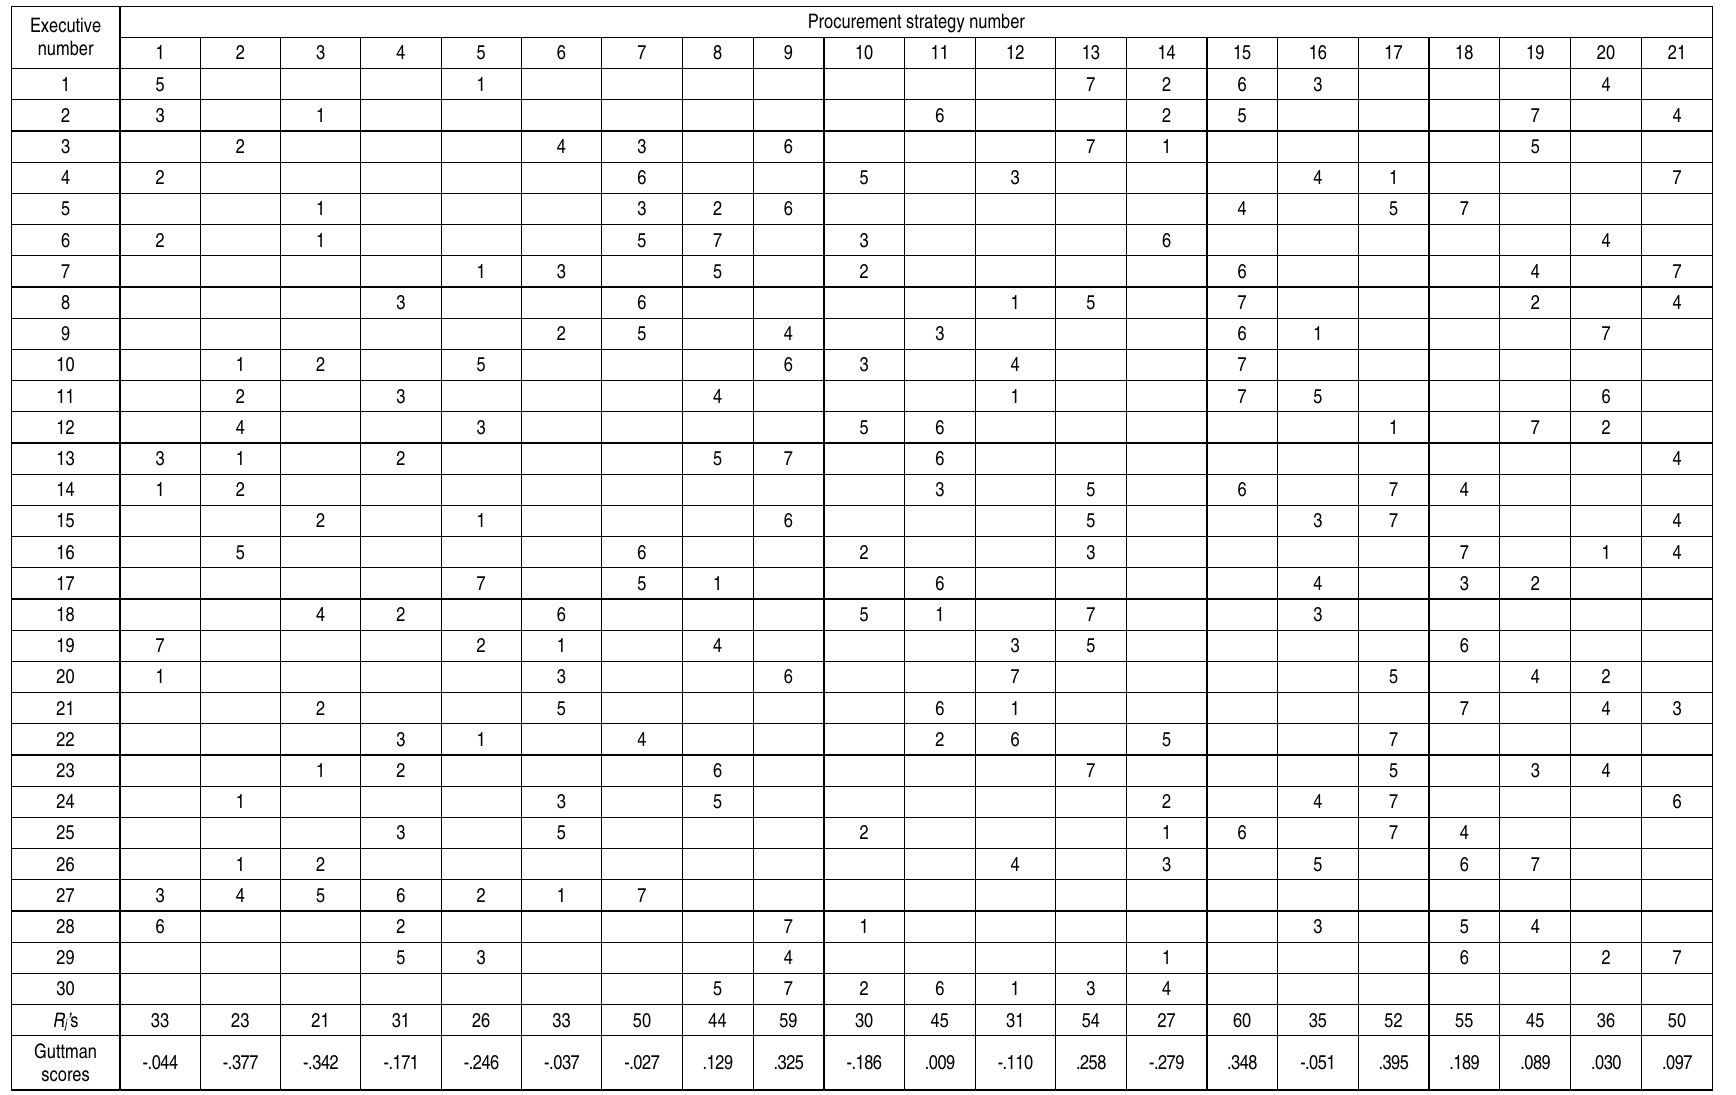
Table 4. Results from BIBD for procurement strategies for the introduction stage of the product life